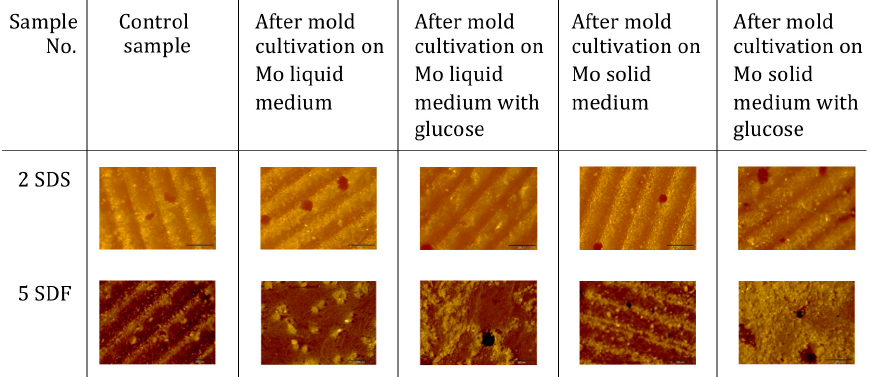
Figure 3. Microscopic observations of selected sulfur copolymers after incubation with molds.